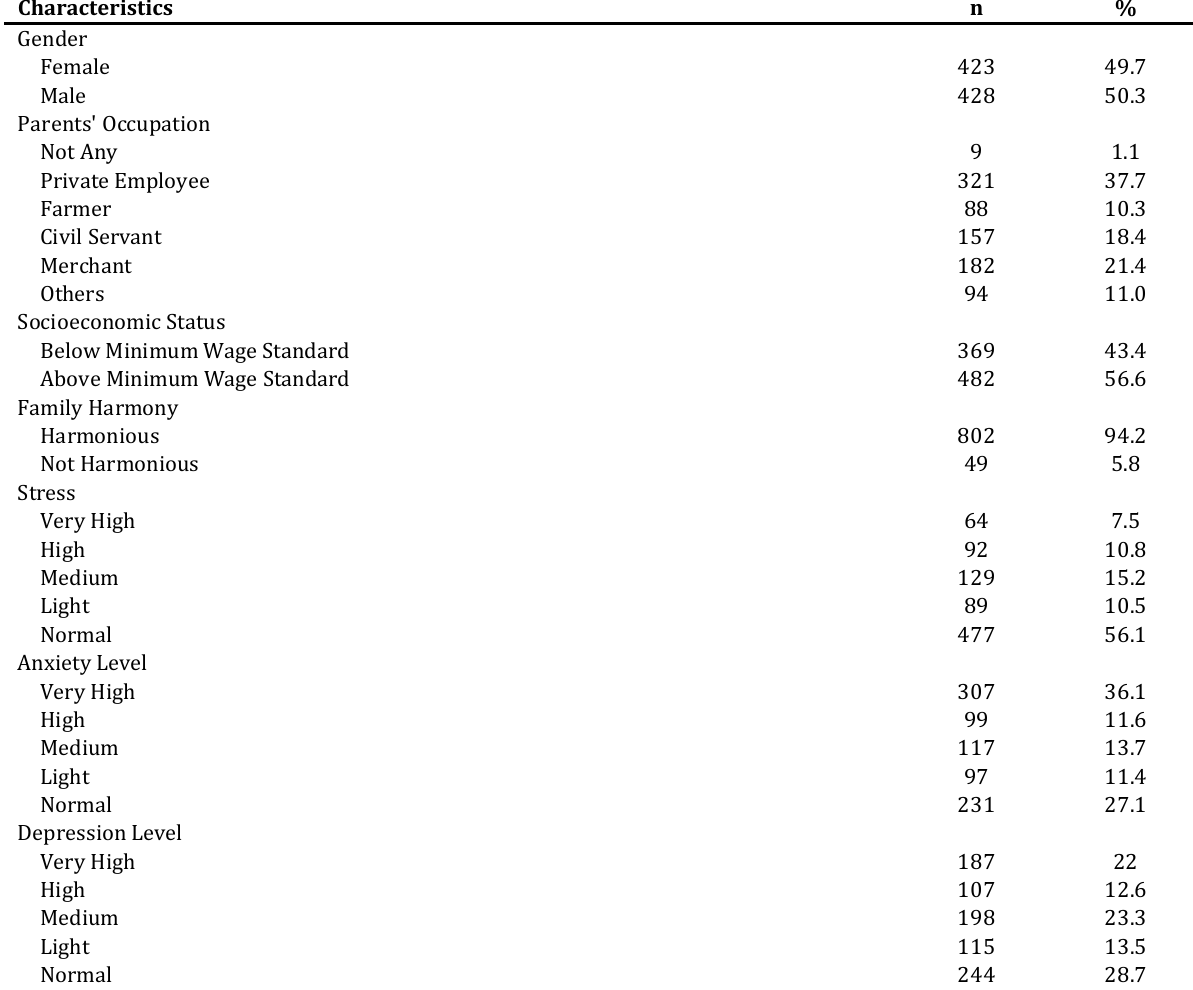
Table 1. Adolescents’ Demography Information (n=851) Characteristics